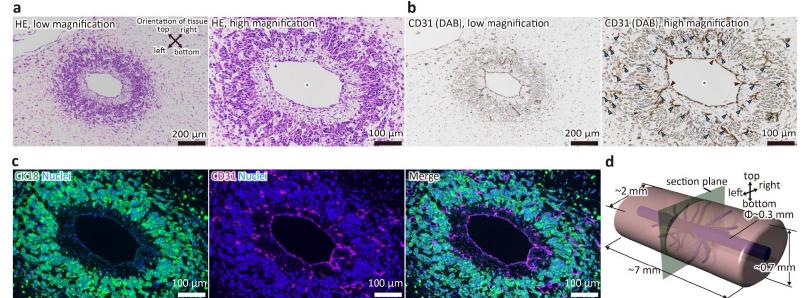
Figure 2. Stained image of a cross-section of the tubular liver tissue perpendicular to the main blood vessel. ( a ) hematoxylin and eosin (HE) staining image. ( b ) immunohistochemistry (IHC) image (CD31). Asterisks indicate the main blood vessels. Blue arrowheads indicate capillaries. Red arrowheads indicate branches from main vessels to capillaries. ( c ) Immunofluorescence image (CK18 and CD31). ( d ) Schematic image of the tubular liver tissue. 3.2. Evaluation of the Proteomic Analysis Process First, to determine whether sufficient tissue was available to obtain the number of cells required for the proteomic analysis, we performed enzymatic dissociation, mechan- ical dispersion, another round of enzymatic treatment, and collection of the liver tissue cells (Figure 1b). In total, (5.25 ± 0.39) × 10 5 cells/device were obtained (Table 1). We also tried the method of only enzymatic treatment for 30 min, without dispersion of the tissue fragments by pipetting, but the number of cells obtained was almost 20-fold lower (2.64 × 10 4 cells/device). As cells and collagen in the tubular liver tissue are tightly packed because of cellular self-assembly, mechanical dispersion had to be performed during the enzy- matic treatment for better cell yield. As the number of cells required for the identification and relative quantification of the expressed proteins in DIA proteomic analysis is 5 × 10 5 cells, the analysis could be performed using only one or two devices. Furthermore, the knowledge of the number of cells that could be obtained from our device in this study is useful because the required number of cells may change, depending on the device used and proteomic analysis method employed. Next, we performed proteomic analysis of the cells from the tubular liver tissue and 2D culture in the quantities indicated in Table 1. As a result, we successfully identified and quantified 6032 and 6034 proteins from tubular liver tissue and 2D cell culture, re- spectively. Since the conditions employed for this analysis were such that 3000–5000 pro- teins could normally be identified and quantified, and the proteomic analysis of 2D cul- tures is a well-established method [17], it can be concluded that detailed proteomic anal- ysis can be performed using tubular liver tissue samples. Table 1. Quantitative characteristics of the experimental systems and proteomic analysis output. Culture Method Number of Obtainable Cells Number of Cells Used for Proteomic Analysis